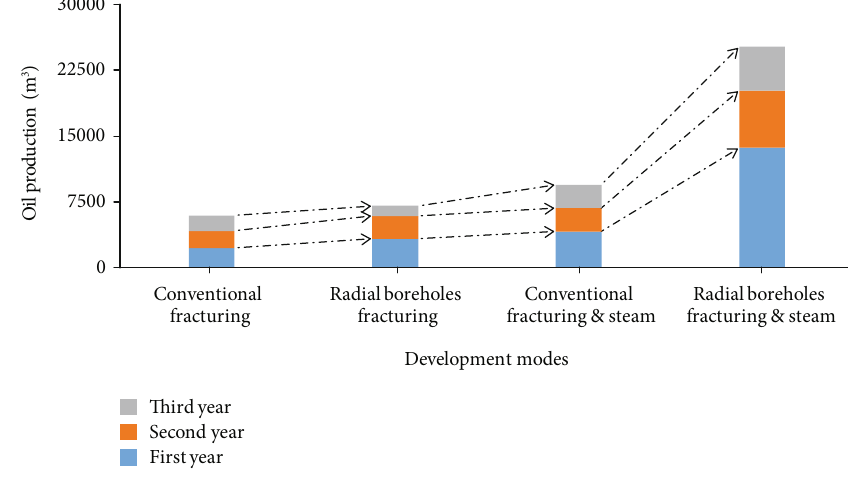
Figure 20: Capacity comparison of di ff erent development